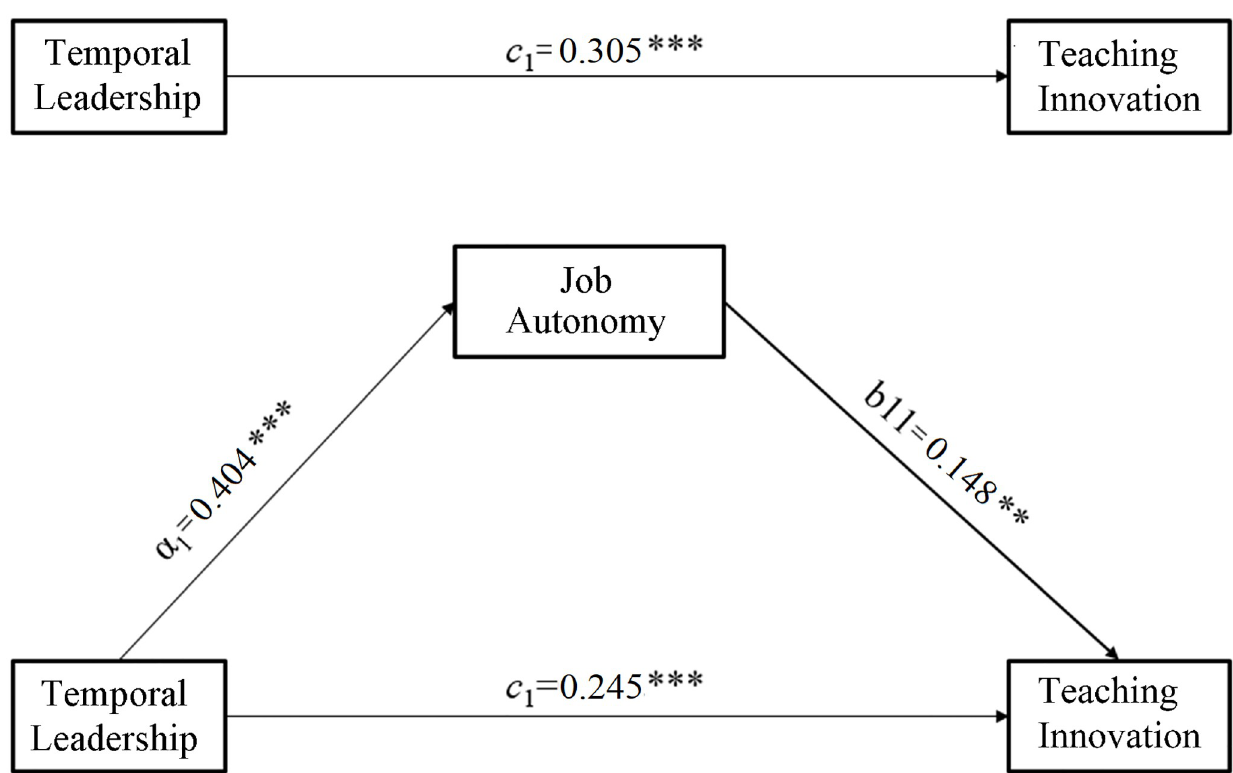
Fig 1. Job autonomy mediates the relationship between temporal leadership and reaching innovation. �� p < 0.01, ��� p < 0.001.